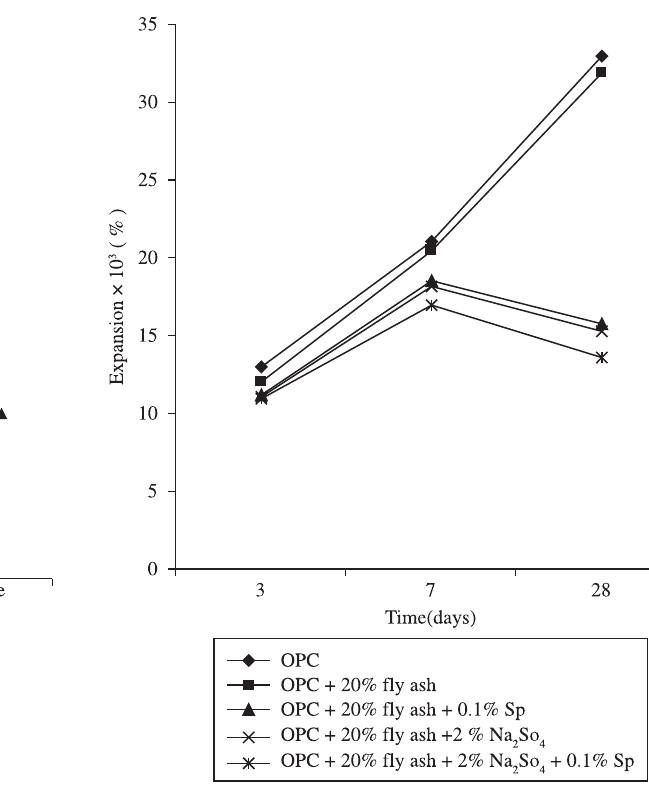
Figure 6. Air content in different system.